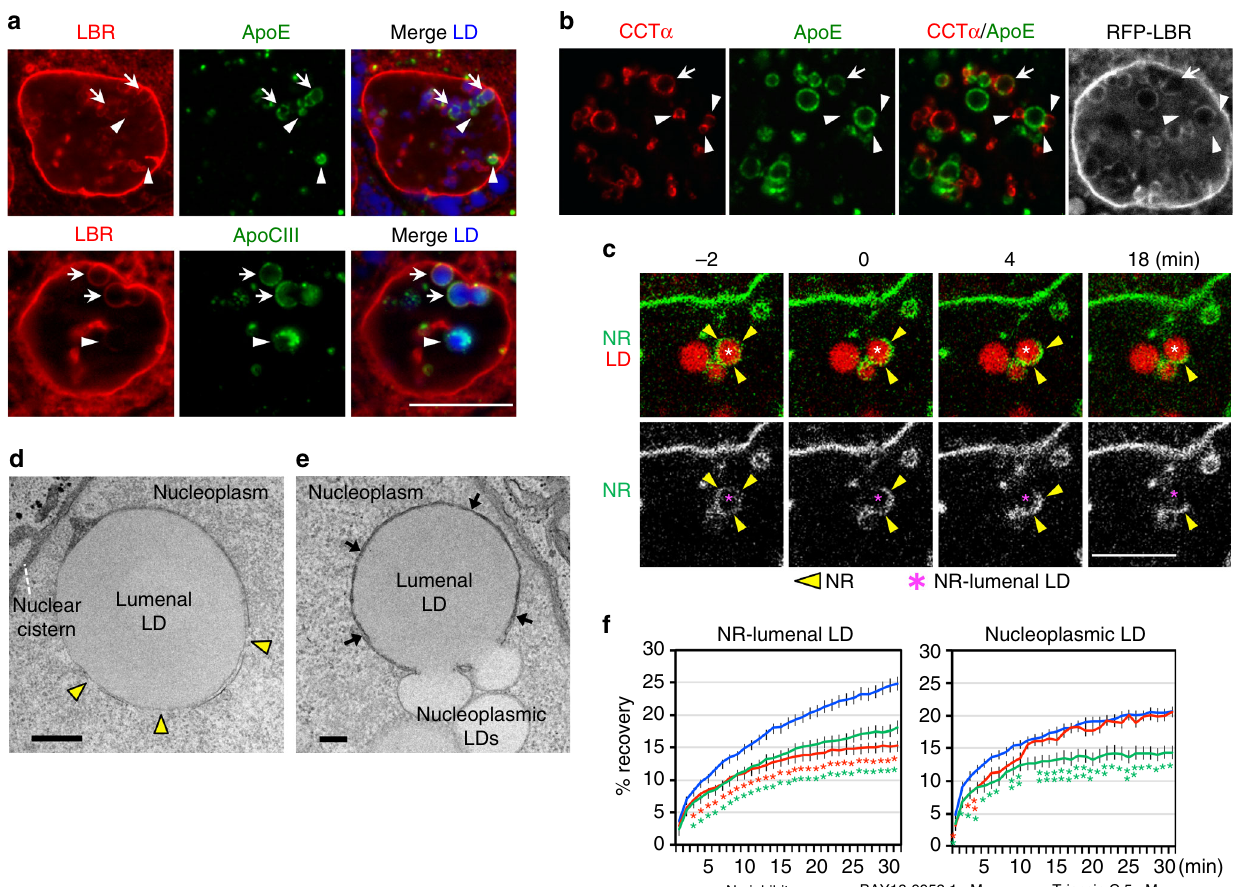
Fig. 3 Nucleoplasmic LDs derive from NR-lumenal LDs. a ApoE and ApoCIII (green) were labeled in NR-lumenal LDs (arrows) and in some nucleoplasmic LDs (arrowheads). RFP-LBR (red), LDs (blue). Bar, 10 μ m. Huh7 treated with OA/TM for 48 h is shown in this and subsequent fi gures. b CCT α (red) colocalized with ApoE (green) in the same LD (arrow) or distributed in small nucleoplasmic LDs (arrowheads) binding to ApoE-positive NR-lumenal LDs. The LBR ring is not distinct around the LD showing CCT α – ApoE colocalization. Bar, 10 μ m. c Live imaging showed that the complete LBR ring (green) around an NR-lumenal LD (red) disintegrates and releases the LD into the nucleoplasm. Bar, 10 μ m. Selected frames from Supplementary Movie 1. d The type I NR membrane around an NR-lumenal LD shows defects (arrowheads). HRP-KDEL was used to delineate the NR lumen by DAB precipitates. Bar, 0.5 μ m. e Coalescence between NR-lumenal and nucleoplasmic LDs through defects in the NR membrane. Arrows indicate the NR. Bar, 0.2 μ m. See Supplementary Fig. 3b for serial sections. f FRAP of LDs labeled with BODIPY 558/568-C 12 . Fluorescence recovery in NR-lumenal LDs was retarded by both triacsin C and BAY 13-9952, whereas that in nucleoplasmic LDs was affected only by triacsin C. Nucleoplasmic LDs clearly separated from LBR rings were chosen. The number of LDs examined: 41 (control), 44 (triacsin C), 40 (BAY 13-9952) (NR-lumenal LDs); 36 (control), 36 (triacsin C), 21 (BAY 13- 9952) (nucleoplasmic LDs). Mean ± SEM. * p < 0.01, ** p < 0.05, one-way ANOVA followed by Tukey test. See also Supplementary Fig. 3c. Source data